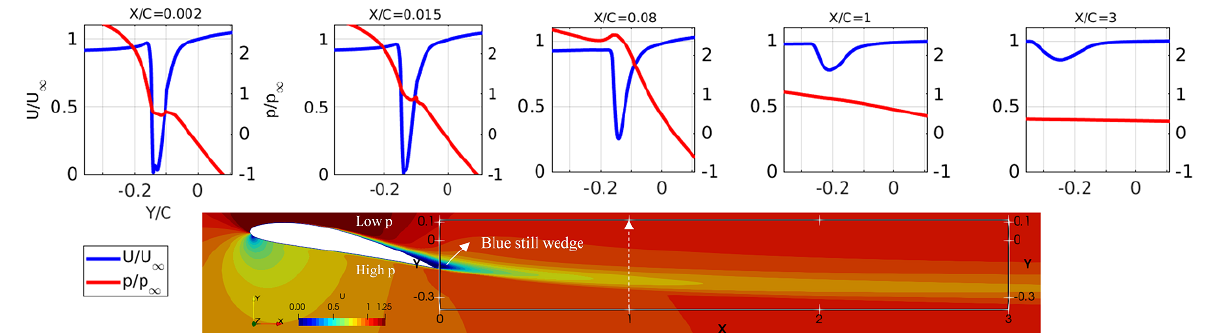
Figure 7. Flow variations across the wake at different streamwise locations from X/C = 0.002 up to X/C = 3. The corresponding box is marked on the velocity contour plot around the airfoil. At each chart, Y-axis on right-hand side shows the pressure ratio and on left-hand side shows the velocity